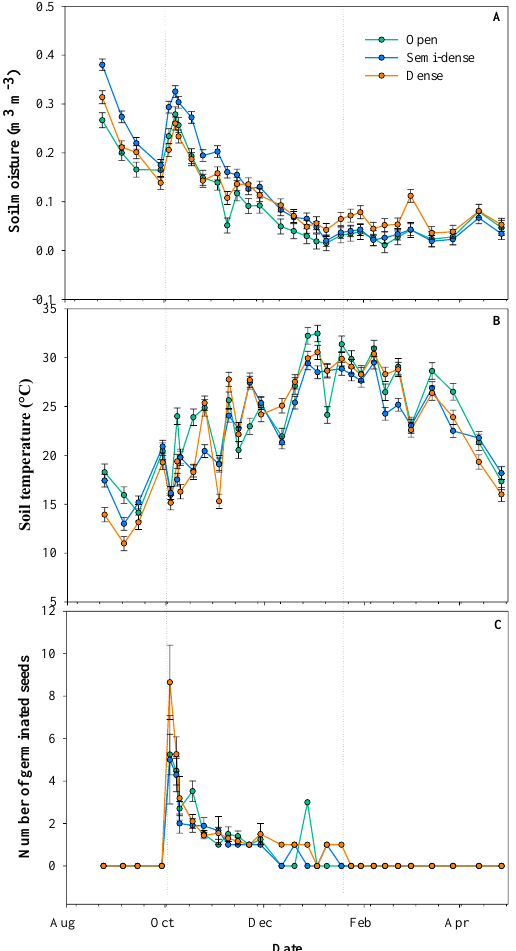
Figure 1. Mean soil moisture ( A ), soil temperature ( B ), and number of germinated and survived seeds ( C ) per forest cover type and date. Germination and survival were expressed based on the 40 initial seeds per mother tree. Errors bars represent the standard error.